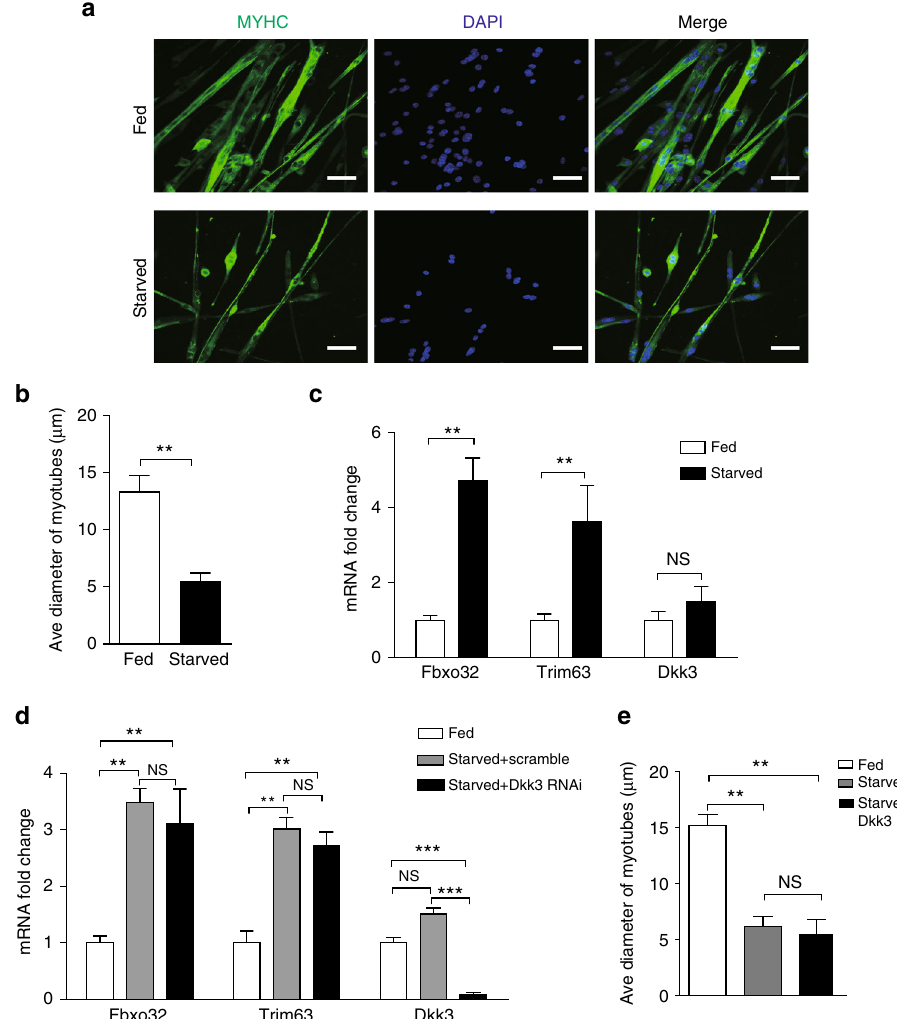
Fig. 5 Starvation-induced muscle atrophy did not depend on Dkk3. a Representative images of atrophy induced by starvation in myotubes. Green indicated MYHC staining; blue indicated DAPI staining of nuclei; Merge indicated merged images of MYHC and DAPI. Scale bars, 50 μ m. b Average diameters of myotubes with or without serum starvation. Error bars indicated s.d. and were based on three independent experiments. ** indicated p < 0.01. c Expression levels of Fbxo32 , Trim63 , and Dkk3 in fed or starved myotubes. Error bars indicated s.d. and were based on three independent experiments. ** indicated p < 0.01. NS indicated no signi fi cant changes. d Dkk3 RNAi showed no effects on Fbxo32 and Trim63 expression level in starved myotubes. Primary myotubes were fi rst serum starved in Hank ’ s buffer. Adenovirus-encoding shRNA against Dkk3 or scramble control was next applied to the starved myotubes. Forty- eight hours after virus infection, the myotubes were harvested and subjected for RT-qPCR analysis of the mRNA levels of Fbxo32, Trim63, and Dkk3 . Error bars indicated s.d. and were based on three independent experiments. ** indicated p < 0.01. NS indicated no signi fi cant changes. e Average diameters of myotubes with or without serum starvation, and Dkk3 RNAi after serum starvation. Error bars indicated by s.d. and were based on three independent experiments. ** indicated p < 0.01. NS indicated no signi fi cant changes. All p -values were based on two-tailed t